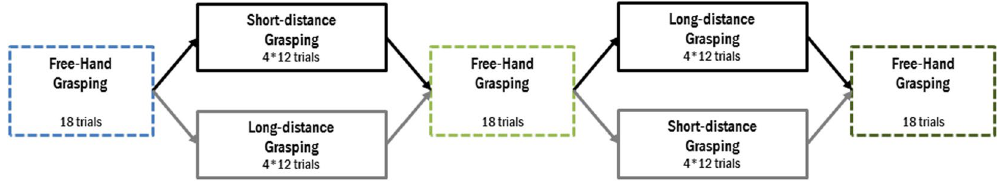
Figure 7. Experiment 2 timeline. Each participant performed two retracted arm posture sessions (Short- Distance and Long-Distance Grasping) preceded and followed by a block of free-hand grasping movements. The order of the two sessions was counterbalanced across